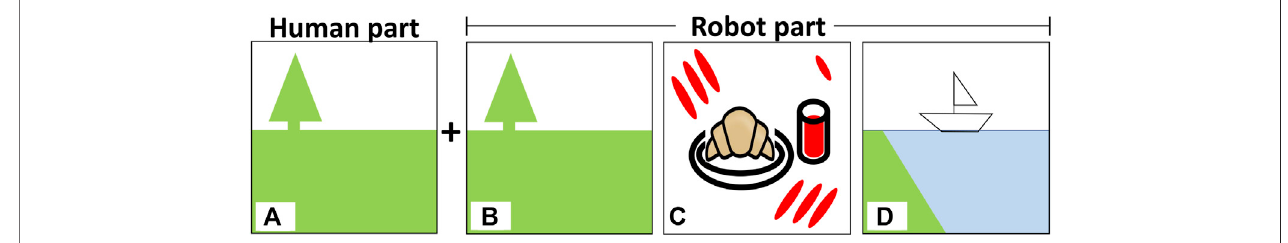
FIGURE 3 | Images used to assess how people feel about a robot ’ s art-making strategy: (A) the human ’ s part, (B) the exogenous system 1 (the robot ’ s art is in fl uencedentirelybywhatthehumandoes), (C) theendogenoussystem2(therobot ’ sartisnotatallin fl uencedbywhatthehumandoes),and (D) theproposedsystem